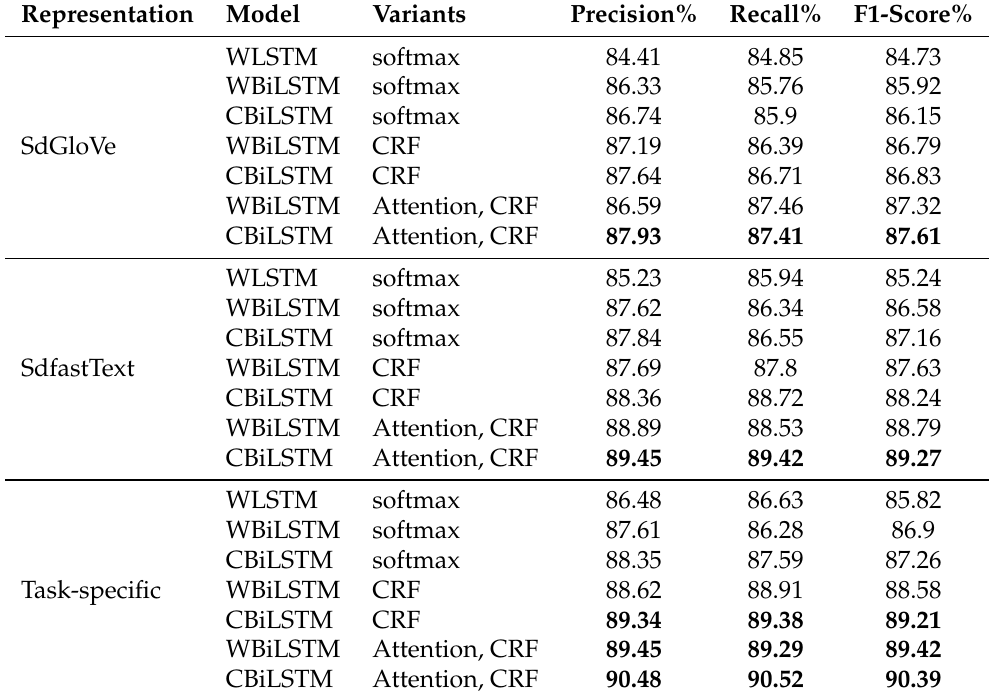
Table 5. Results of neural baseline models on the SiNER test set on the pretrained and task-specific character-level and word-level representations. Bold font denotes the best results.